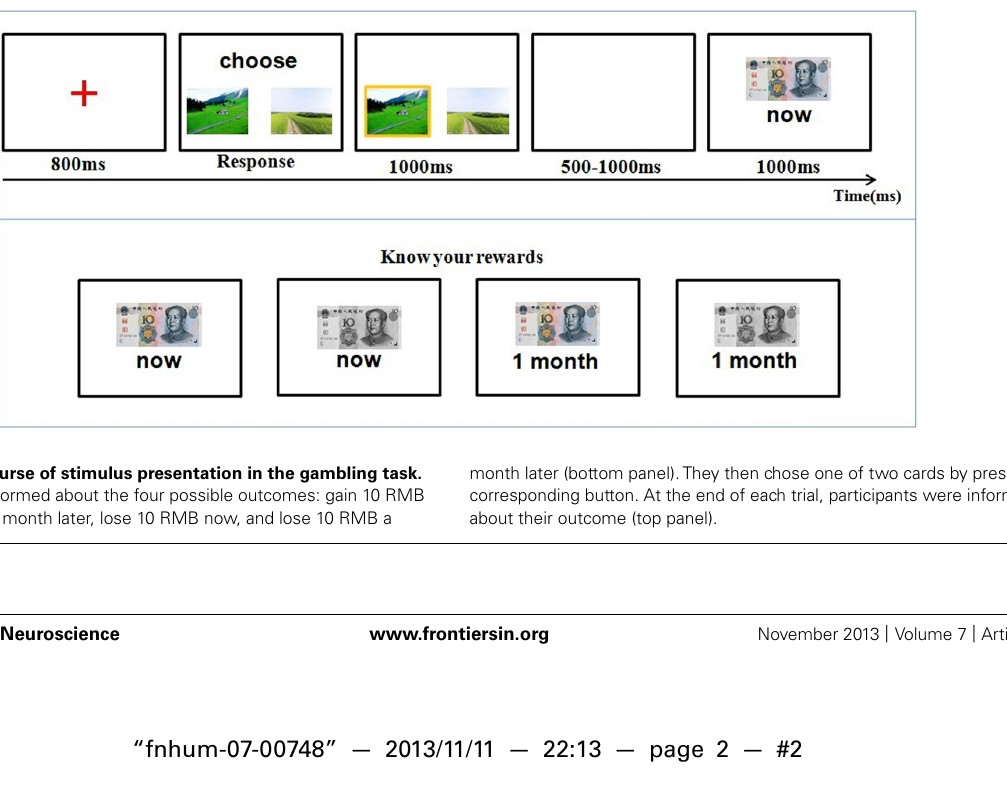
FIGURE 1 |Time course of stimulus presentation in the gambling task. Participants were informed about the four possible outcomes: gain 10 RMB now, gain 10 RMB a month later, lose 10 RMB now, and lose 10 RMB a